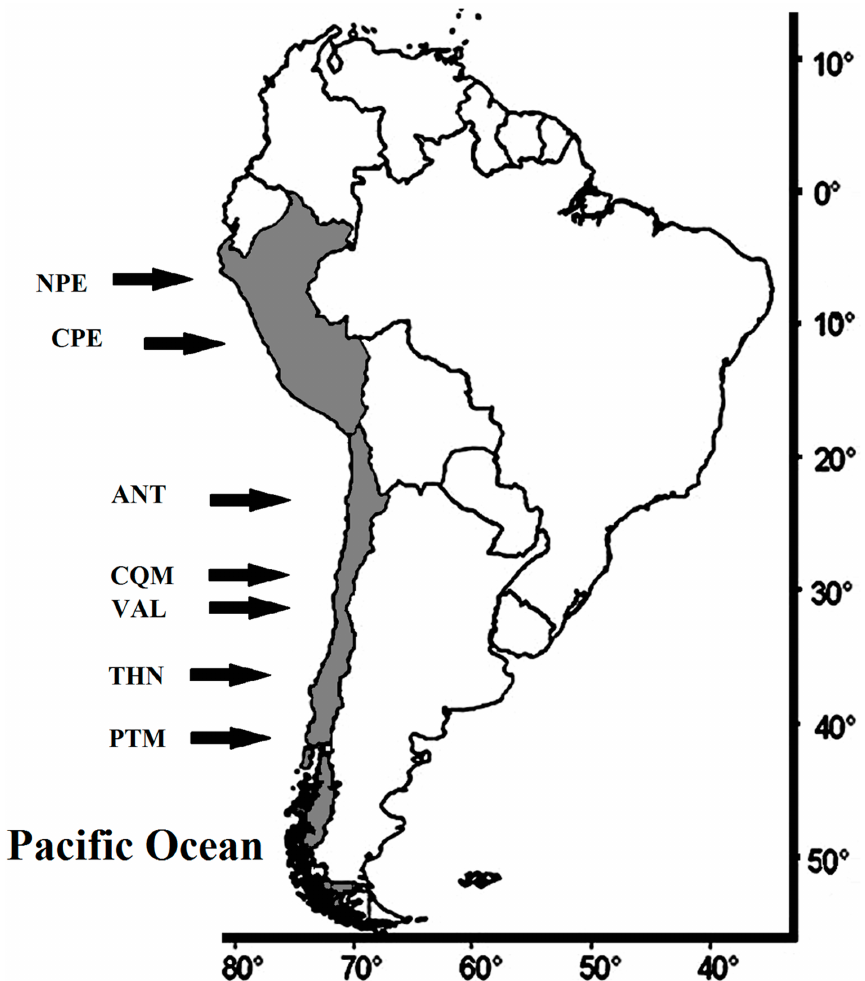
Figure 1. Approximate position of sampling localities. NPE = Paita 5 ◦ S (Northern Peru); CPE = Callao 12 ◦ S (Central Peru); ANT = Antofagasta 23 ◦ 40 (cid:48) S (Chile); CQM = Coquimbo 30 ◦ S (Chile); VAL = Valparaiso 33 ◦ S (Chile); THN = Talcahuano 36 ◦ 40 (cid:48) S (Chile); PTM = Puerto Montt 41 ◦ 30 (cid:48) S